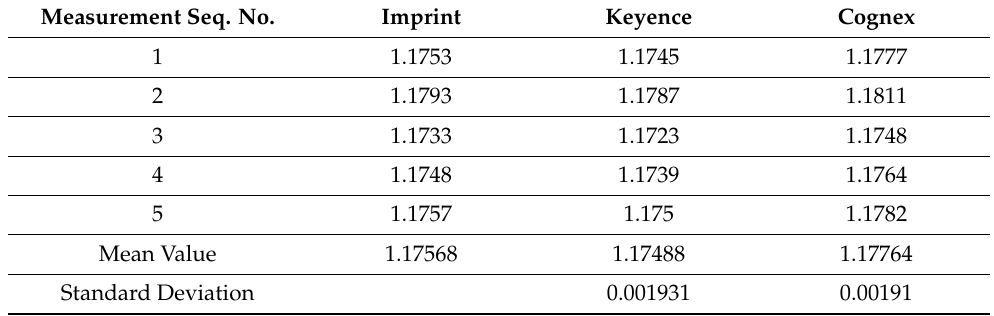
Table 1. Fillet radius R01 measurement.